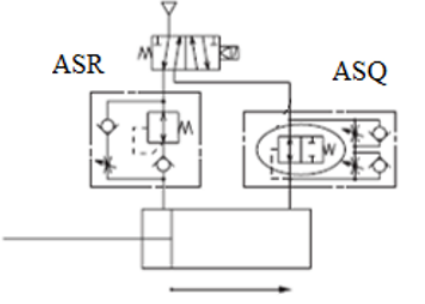
Fig. 9. Connection of ASQ valve